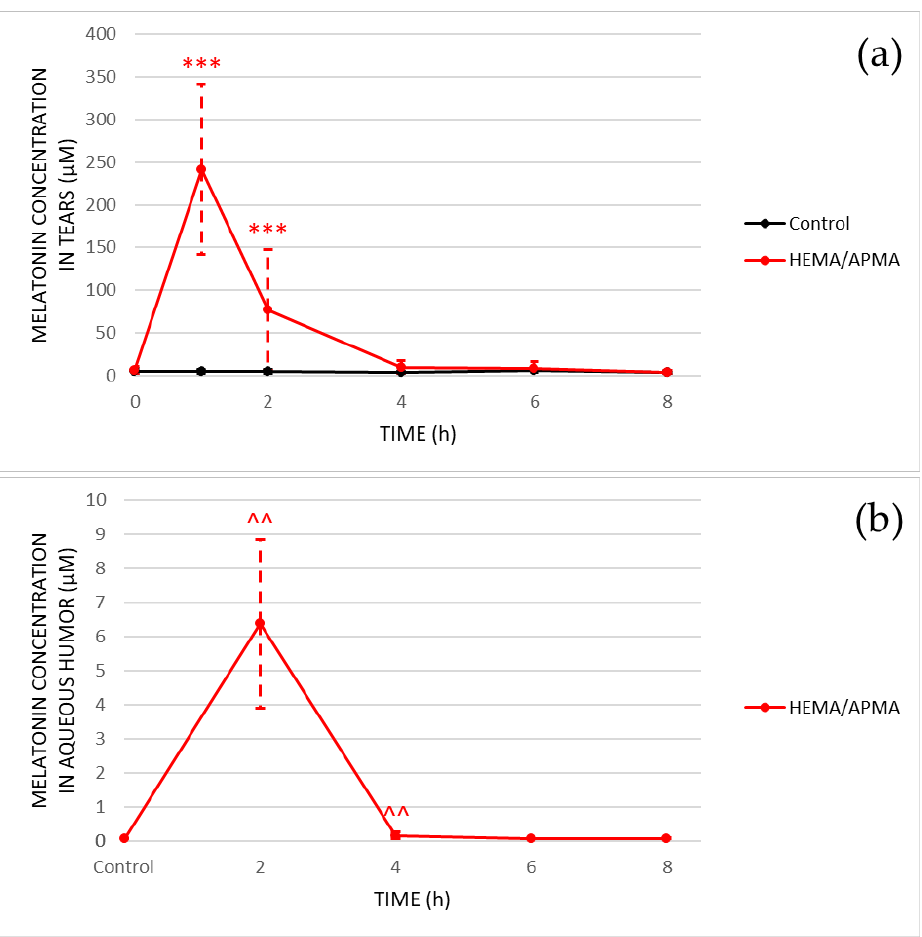
Figure 7. In vivo release of melatonin with the HEMA/APMA contact lenses. ( a ): Results of the melatonin concentration in the tears of rabbits at the baseline ( n = 12) and after 1, 2, 4, 6, and 8 h of wearing the contact lenses ( n = 12, 12, 9, 6, and 3, respectively). The control group represents 3 rabbits without contact lenses. *** p < 0.001, Wilcoxon test, comparison with the baseline. ( b ): Results of the melatonin concentration in the aqueous humor of rabbits after being sacrificed at the baseline (control group) and after 2, 4, 6, and 8 h of wearing the contact lenses ( n = 3, each group). ˆˆ p < 0.01, Mann–Whitney U test, comparison with the